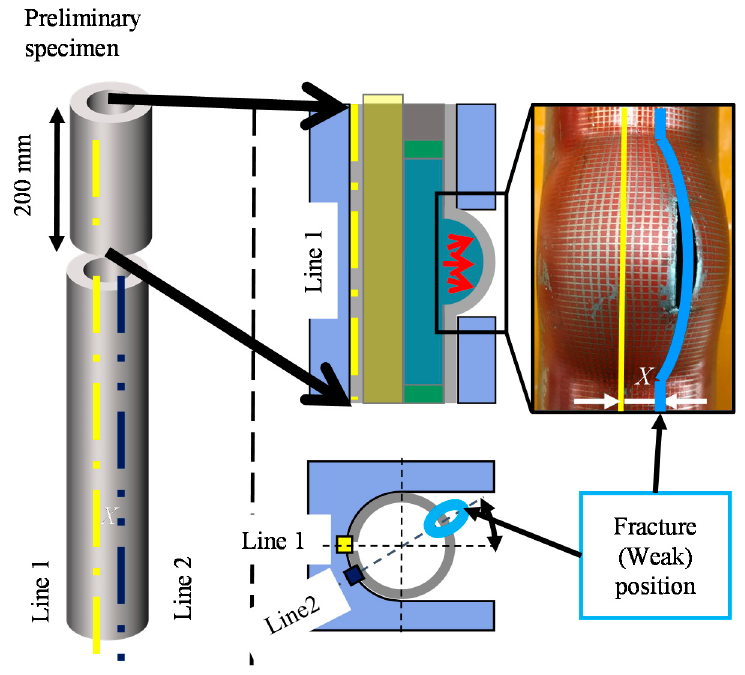
Figure 5. Overview of the preliminary test to determine the weak position.